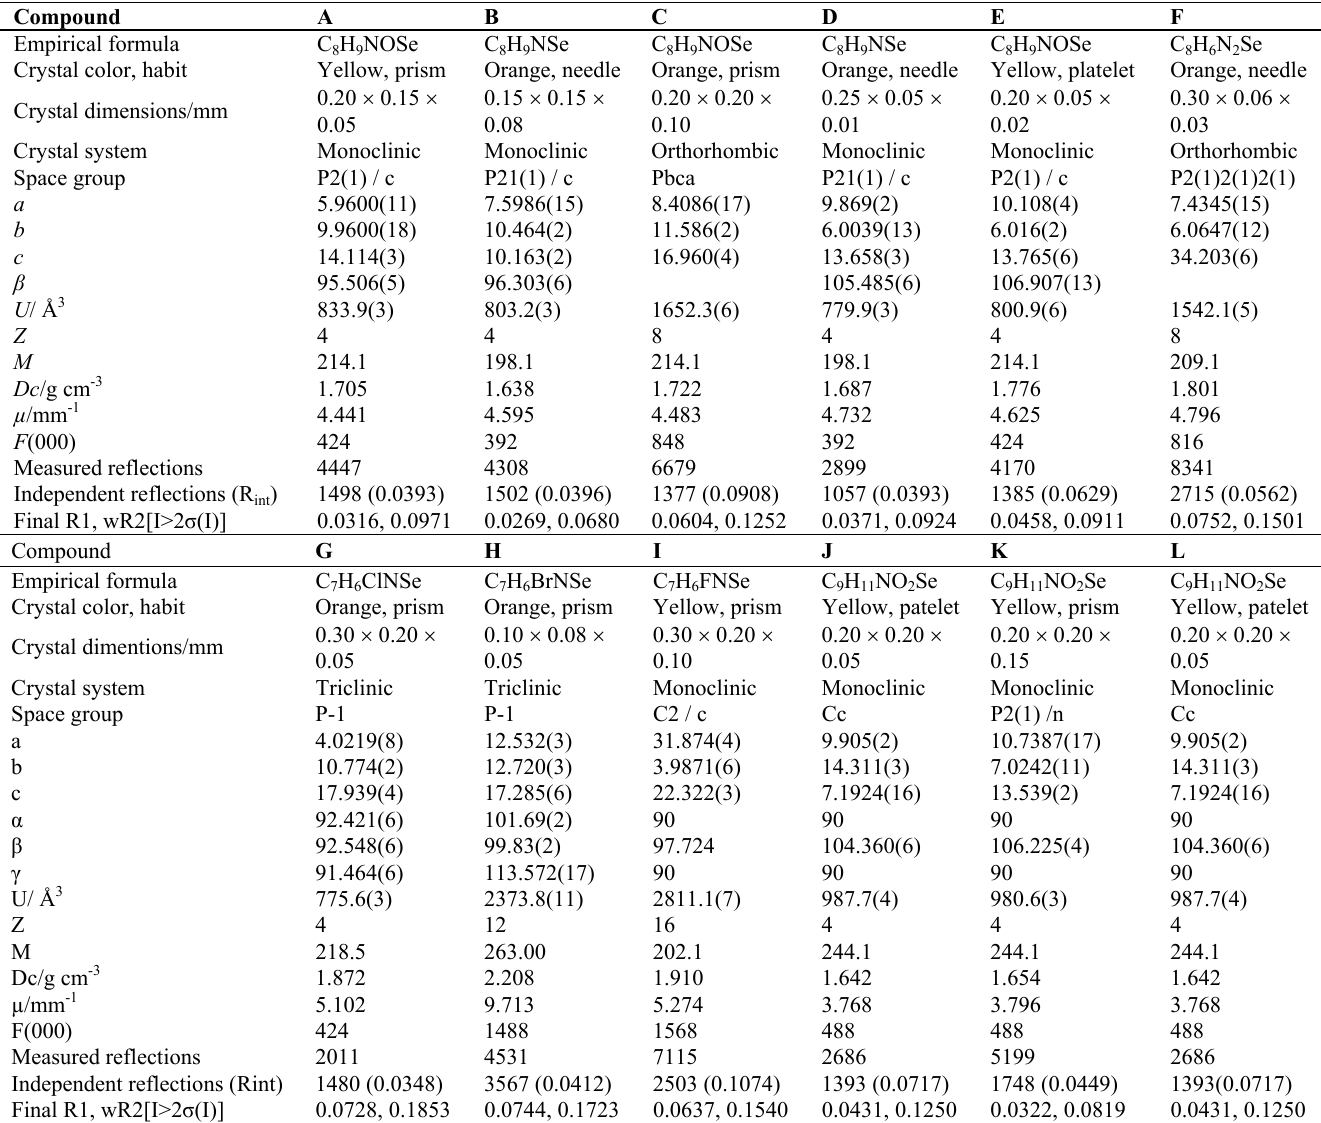
Table 3. Details of data collections and refinements for A - L